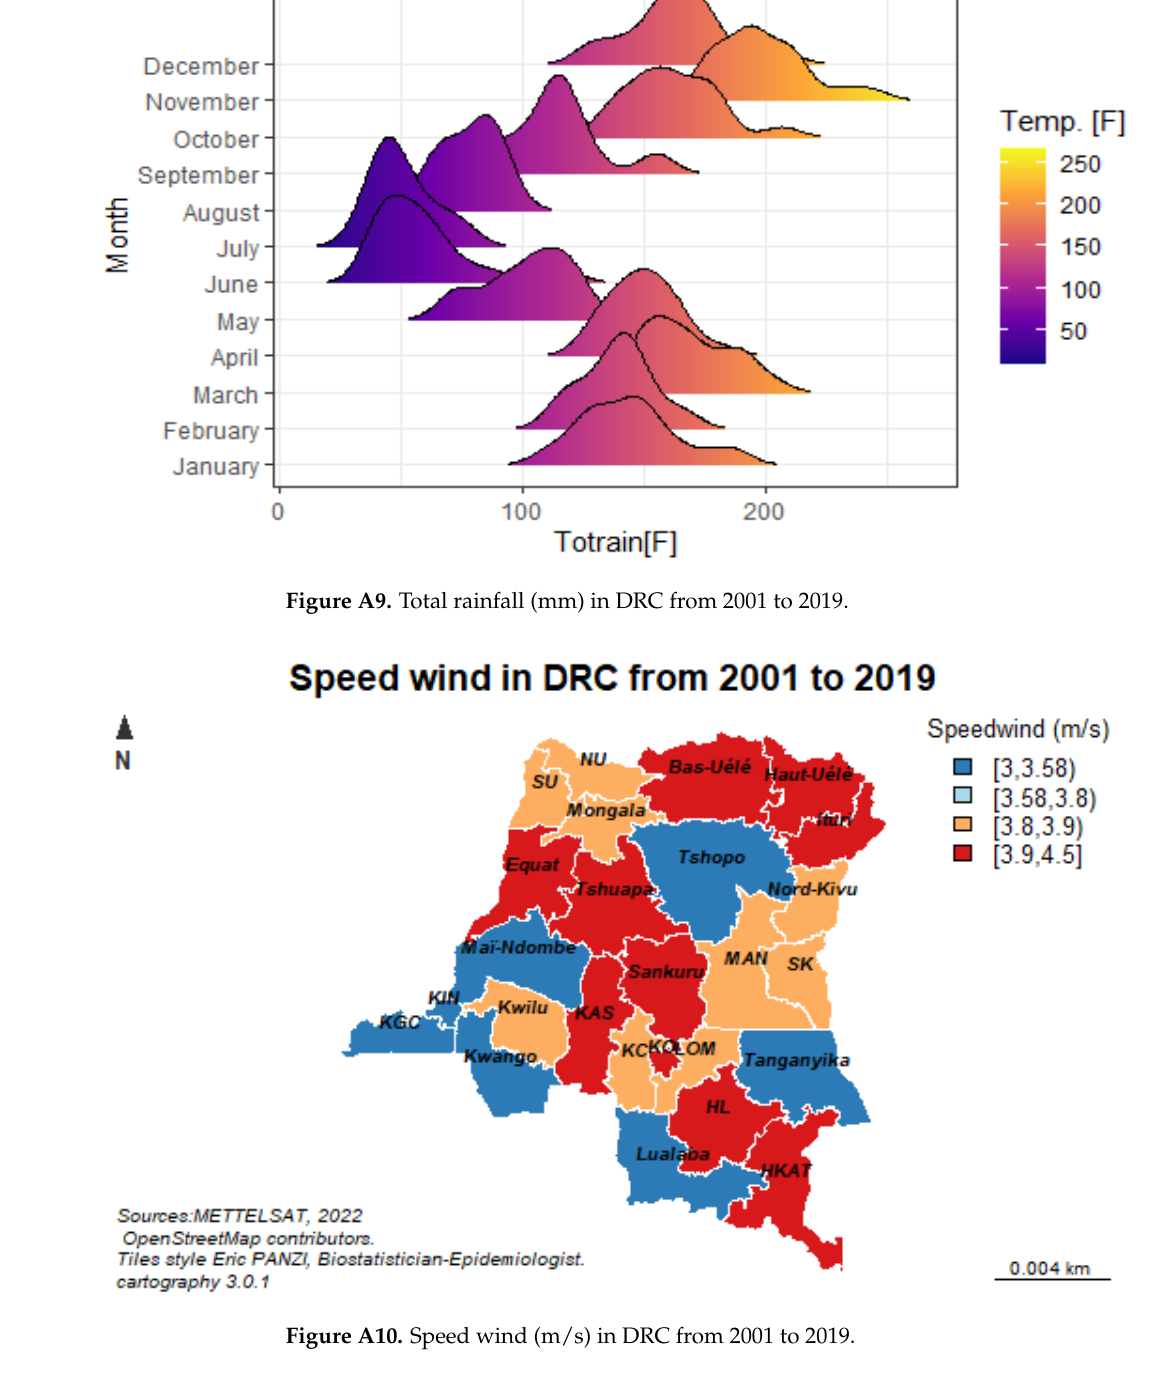
Figure A10. Speed wind (m/s) in DRC from 2001 to 2019.